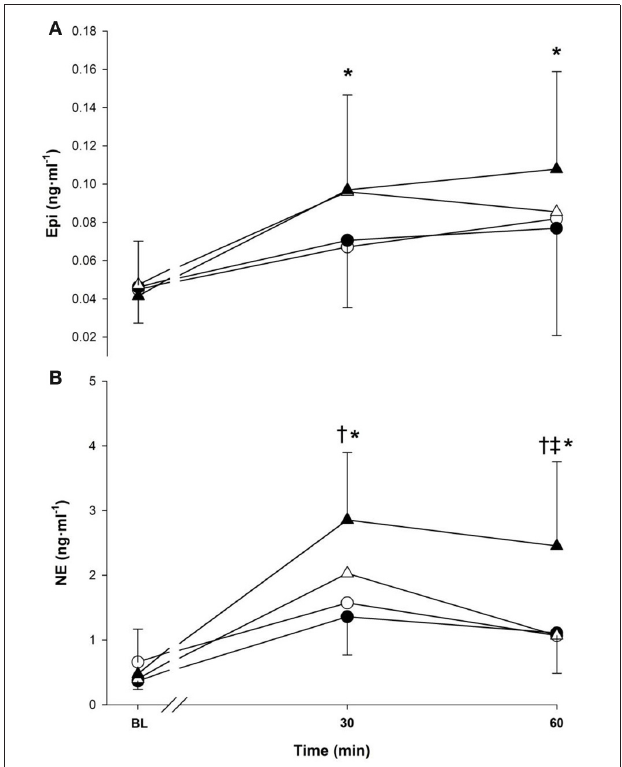
FIGURE 4 | Epinephrine (panel A), norepinephrine (panel B) at baseline (BL) and during 60-min of exercise during walking ( (cid:2) and • ) and running ( (cid:2) and (cid:2) ), in cold ( (cid:2) and (cid:2) ), and neutral ( • and (cid:2) ) ambient temperatures. Mean ( ± SD). † Significant difference between walking and running ( P < 0 . 01). ‡ Significant difference between cold and neutral ( P < 0 . 05), ∗ Significantly greater than baseline ( P < 0 . 05).